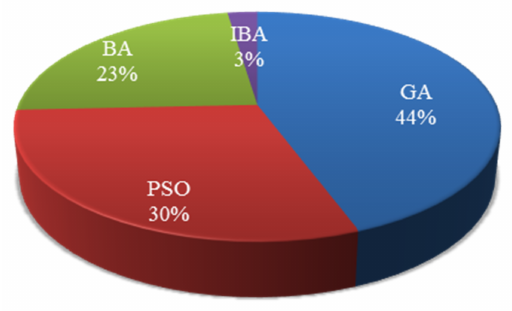
Figure 10. Cost saving of GWO compared with other algorithms in Scenario